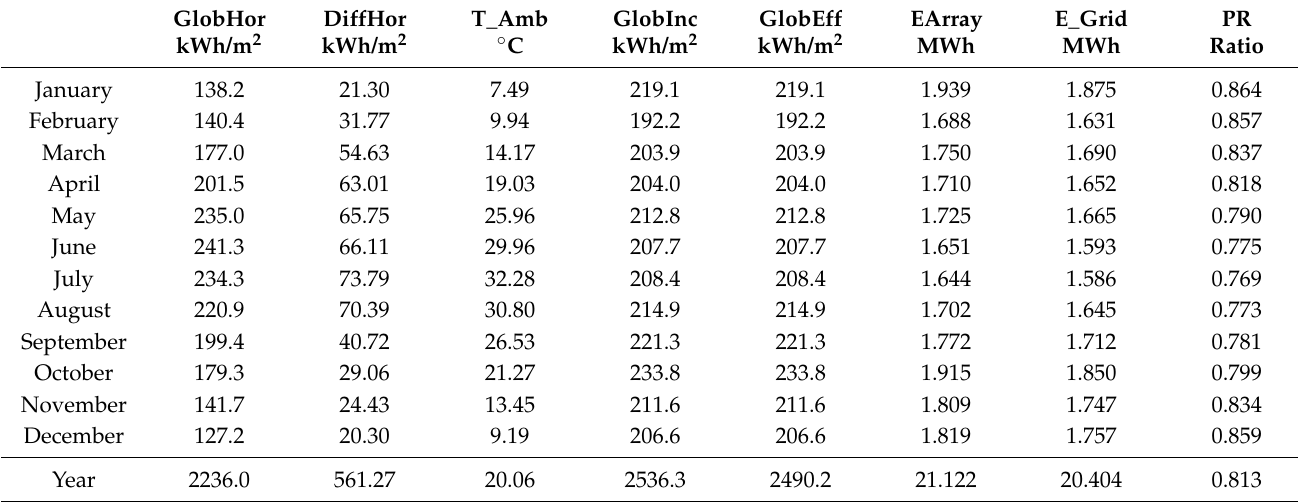
Table 4. Balance and main results for the Darab area in 2022.